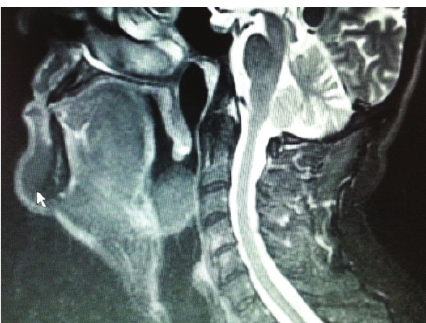
Figure 1: A 4 × 3 cm cystic mass filling the epiglottic vallecula and obstructing the airway.